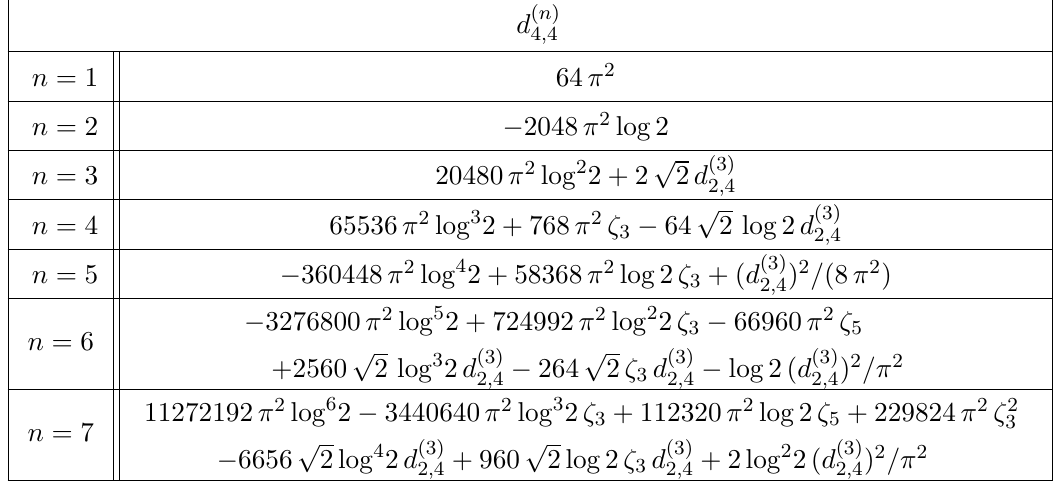
in the strong-coupling expansion of D 4 , 4 . 4 , 4